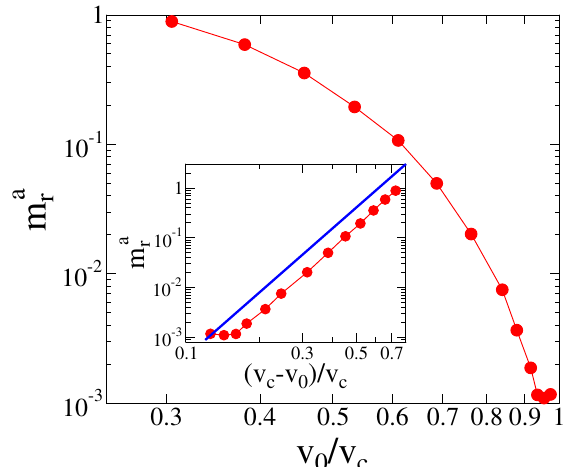
Figure 5. Asymptotic mass m a r of the residue as a function of the impact velocity in the abrasion phase v 0 < v c . Inset: the mass values of the main panel are re-plotted as a function of the relative distance from the critical point v c . The straight line represents a power law of exponent β = 4.2